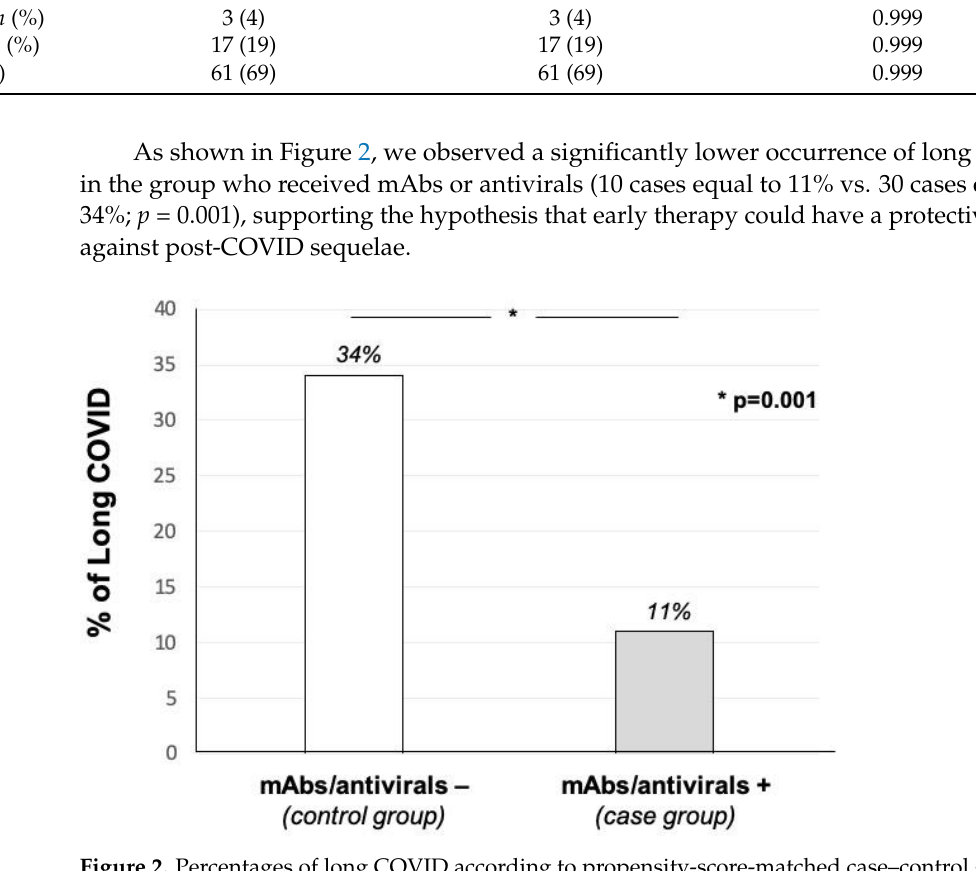
Figure 2. Percentages of long COVID according to propensity-score-matched case – control groups.